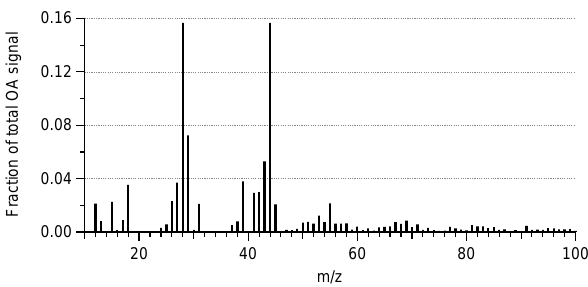
Figure 6. Normalised mass spectrum of marine OA measured over the NW coast on 5